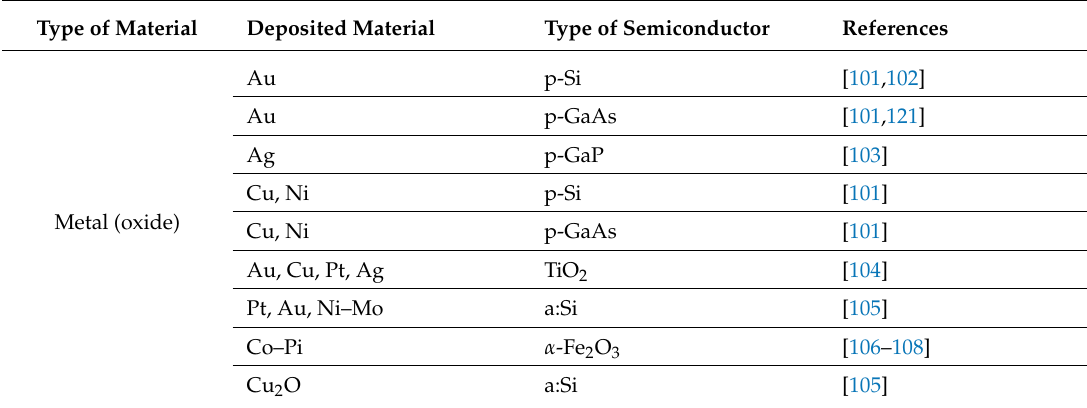
Summary of feasible materials which can be photoelectrochemically deposited on semiconductor